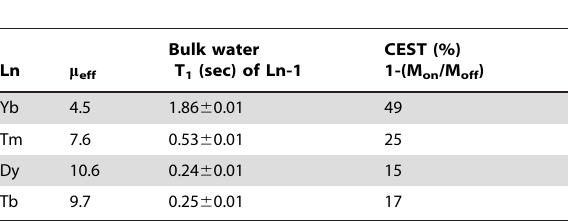
Table 2. The effective magnetic moment ( m eff ) [9] of the four lanthanide ion complexes and the measured T 1 (sec) 6 s.d. of bulk water in 20 mM samples of LnDOTA-(gly) 4 2 .